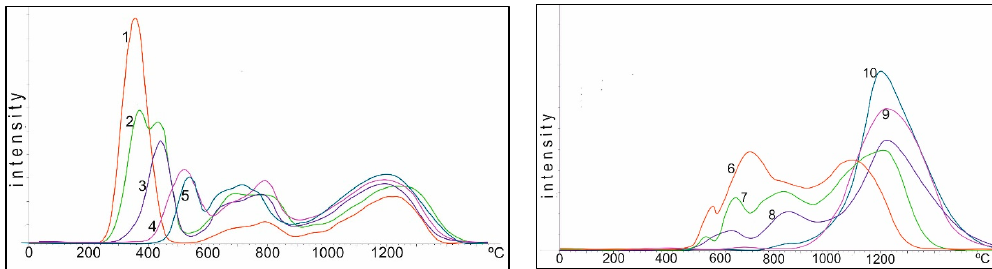
Figure 9. TPR data for 10% Co/Al 2 O 3 calcined in air at 25–1100 ° С ; 1. 25, 2. 300, 3. 400, 4. 550, 5. 650,